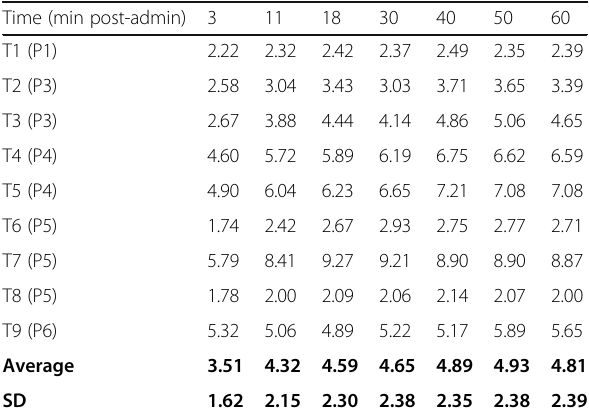
Table 5 T/L measured for nine lung tumors as a function of the time elapsed after radiopharmaceutical administration. In bracket, we indicated the patient identifier Time (min post-admin) 3 11